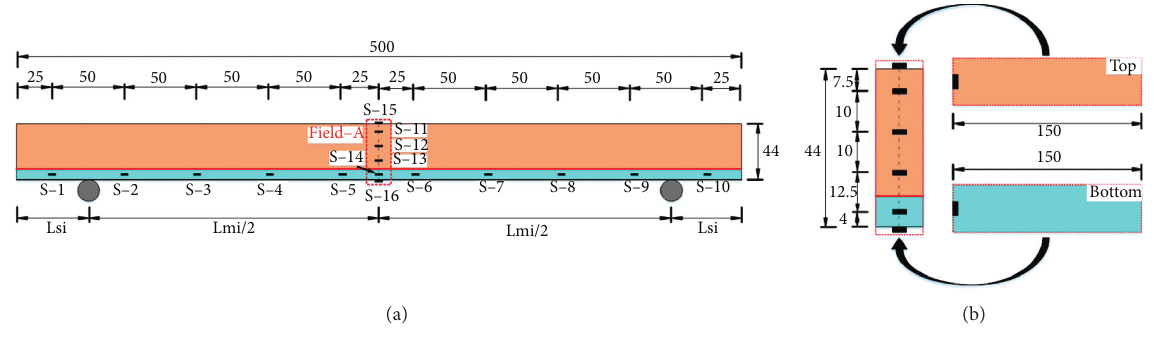
Figure 5: Distribution of Strain gauges. (a) Back view. (b) Field